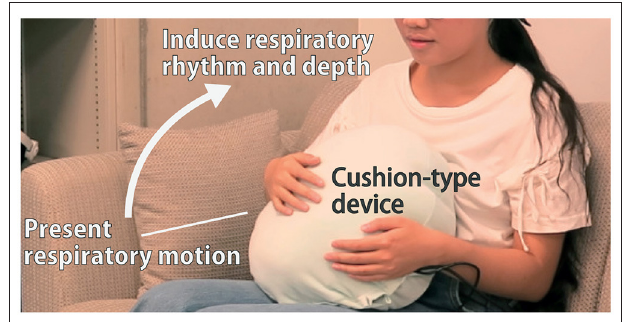
FIGURE 1 | The cushion-type device presents breathing motion. By holding the device on the user’s stomach, their breathing rhythm and depth can be